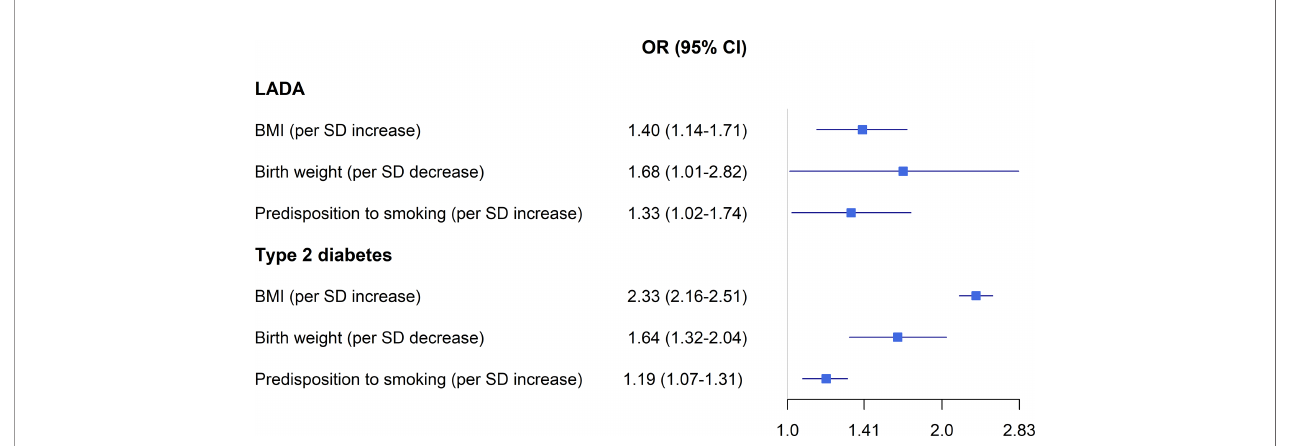
FIGURE 2 | BMI, birth weight, smoking and the risk LADA compared to type 2 diabetes- fi ndings from Mendelian randomization studies. Odds ratios extracted from references (36) and